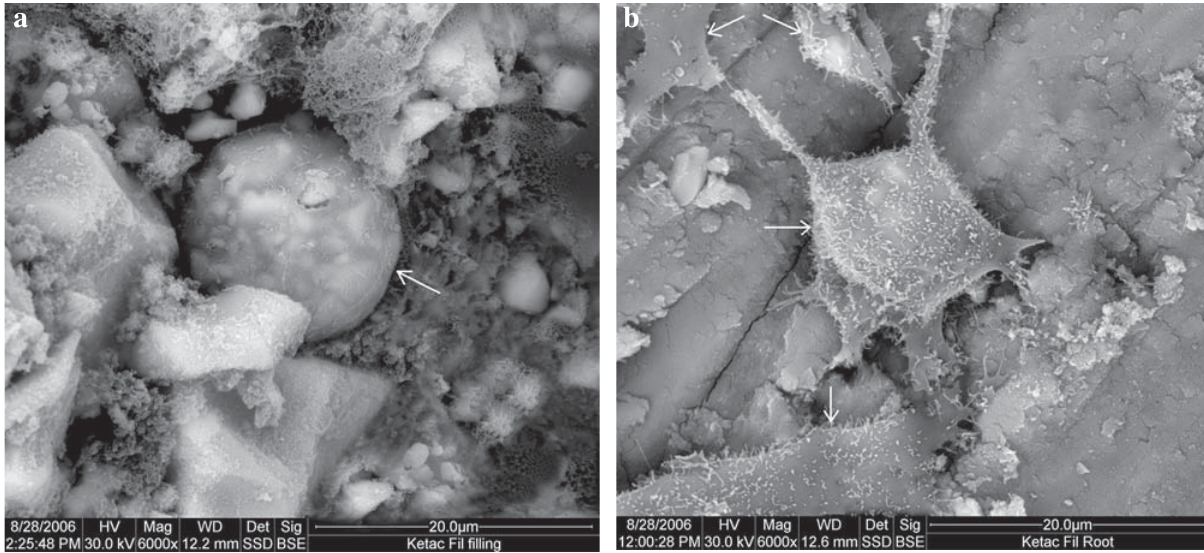
Figure 7 (cid:7)(cid:12)(cid:31)(cid:21)(cid:15)(cid:6)(cid:6)(cid:5)(cid:6)(cid:13)(cid:12)(cid:3)(cid:14)(cid:3)(cid:21)(cid:17)(cid:16)(cid:9)(cid:6)(cid:12)(cid:8)(cid:5)(cid:21)(cid:16)(cid:9)(cid:4)(cid:21)(cid:9)(cid:22)(cid:3)(cid:12)(cid:24)(cid:31)!"(cid:29)(cid:12)(cid:8)(cid:5)(cid:21)(cid:16)(cid:9)(cid:13)(cid:16)(cid:15)(cid:22)(cid:18)(cid:12)(cid:9)(cid:23)(cid:12)N(cid:3)(cid:17)(cid:15)(cid:21)(cid:12)Q(cid:5)(cid:14)%(cid:12)(cid:24)(cid:15)(cid:29)(cid:12)(cid:8)(cid:15)(cid:17)(cid:3)(cid:16)(cid:5)(cid:15)(cid:14)(cid:12)(cid:4)(cid:19)(cid:16)(cid:23)(cid:15)(cid:21)(cid:3)(cid:12)(cid:24)(cid:9)(cid:16)(cid:5)(cid:13)(cid:5)(cid:6)(cid:15)(cid:14)(cid:12)(cid:8)(cid:15)(cid:13)(cid:6)(cid:5)(cid:11)(cid:21)(cid:15)(cid:17)(cid:5)(cid:9)(cid:6)(cid:12)’(cid:26)(cid:27)(cid:27)(cid:27)(cid:28)(cid:29)*(cid:12)